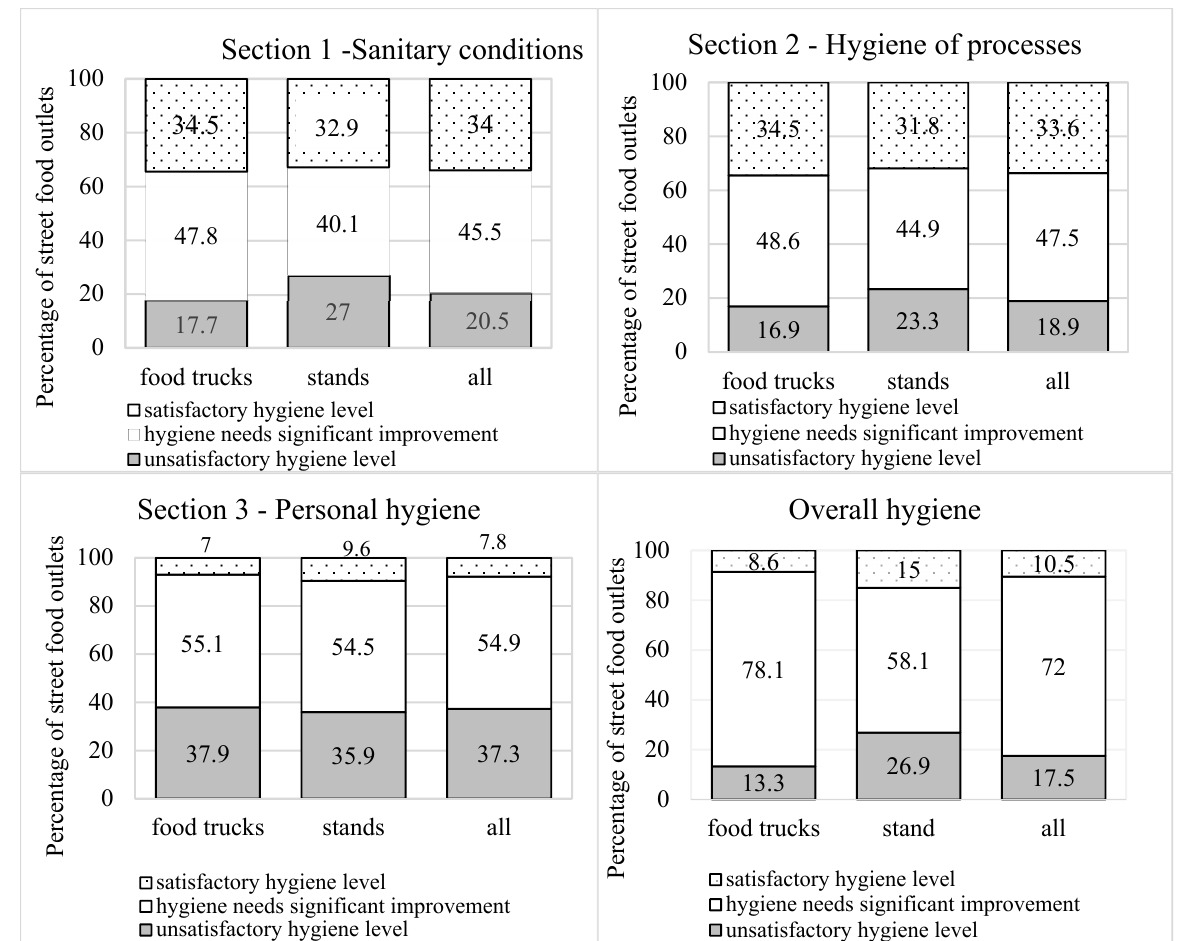
Figure 1. Percentage of street food outlets compliance with different aspects of hygienic rules: 0–50%—unsatisfactory hygiene level, 51–75%—hygiene needs significant improvement, 76–100%—satisfactory hygiene level.